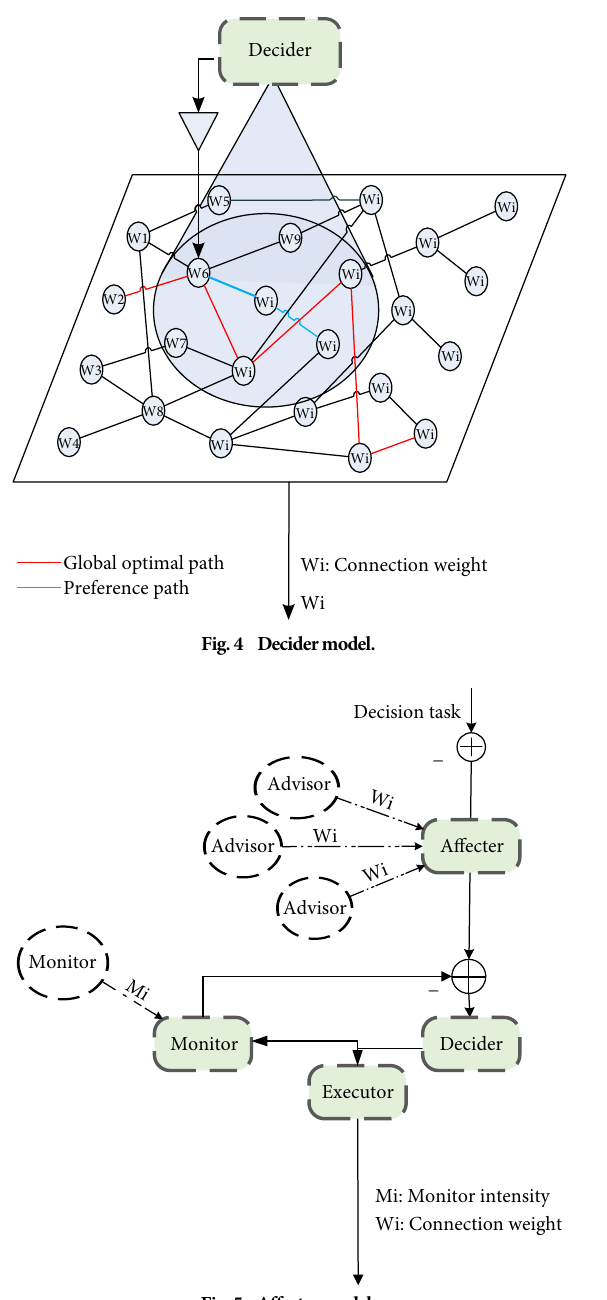
Fig. 5 Affecter model.